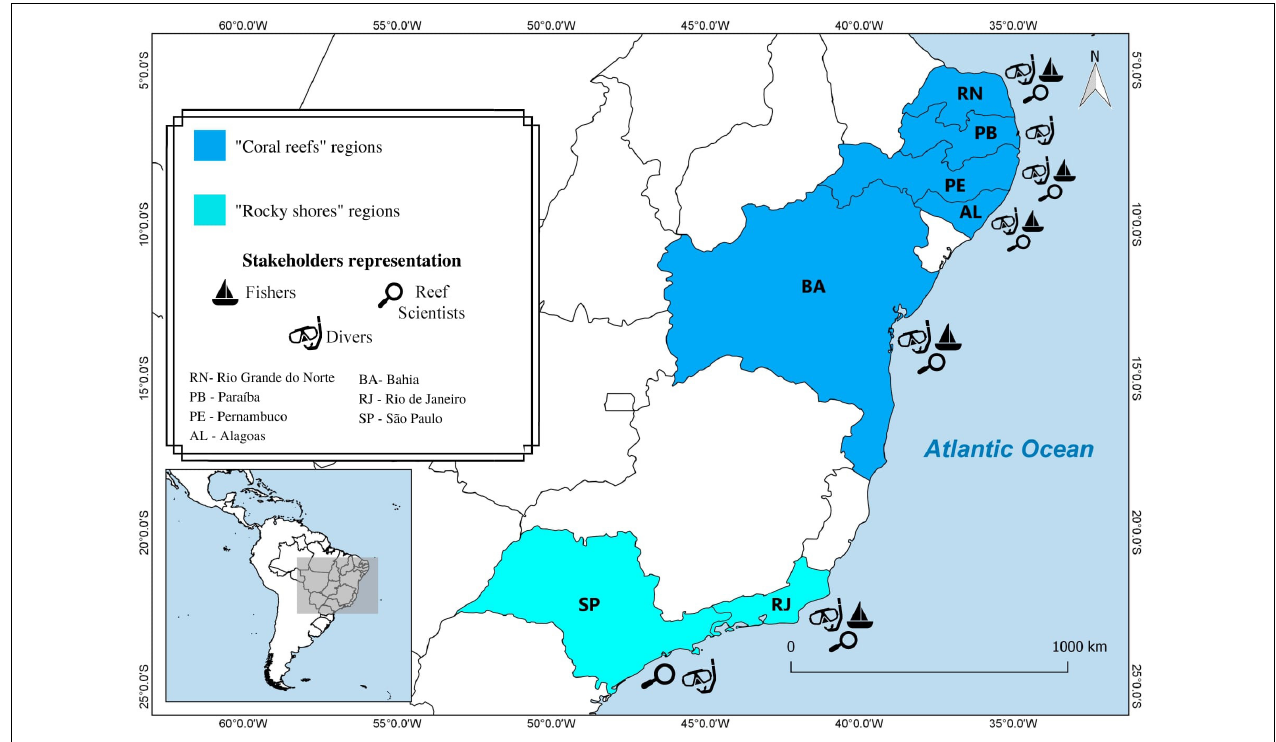
FIGURE 1 | States, where stakeholders were interviewed, are highlighted and divided between the region where coral reefs (states in darker blue) and rocky reefs (states in light blue) are found. It is shown which stakeholders were interviewed in each state: fishers with a sailboat, divers represented with a snorkel, and reef scientists symbolized with a hand glass. The map on the bottom left showing South America, localizing